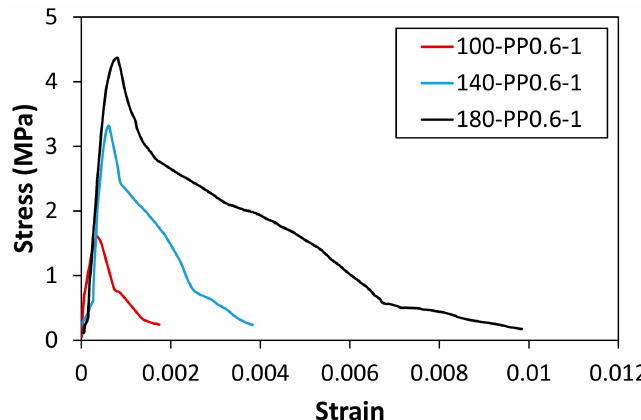
Figure 6. Residual tensile strength for different matrix strengths after 1 h